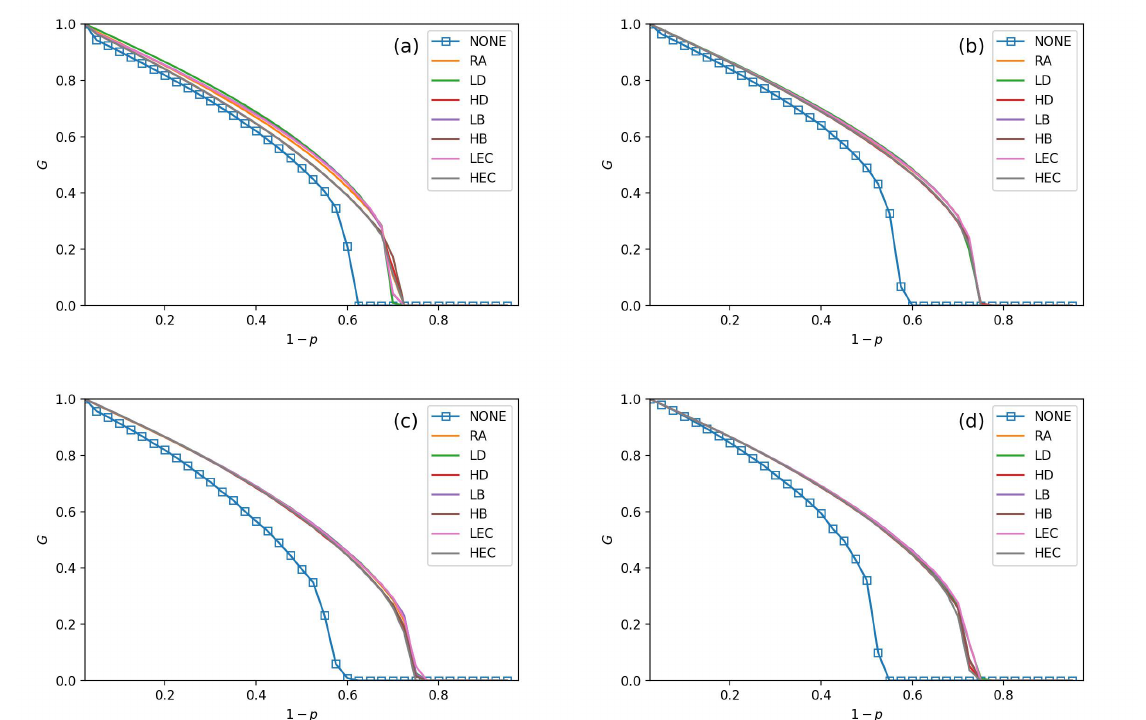
Figure 4. The fraction of function nodes when f L = 25% in ER-ER, ER-SF, SF-ER, and SF-SF system, which is shown in ( a – d